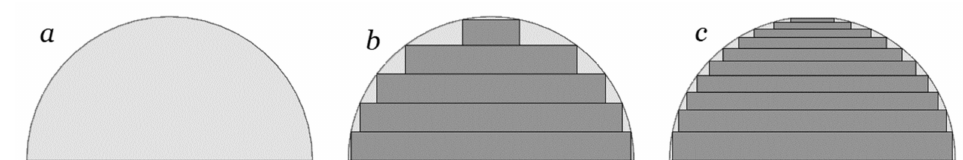
Figure 2. Varying layer thickness achieves better geometry: ( a ) the designed geometry, ( b ) the sliced toolpath with equal layer thickness, printed in the dark area, and ( c ) varying thickness